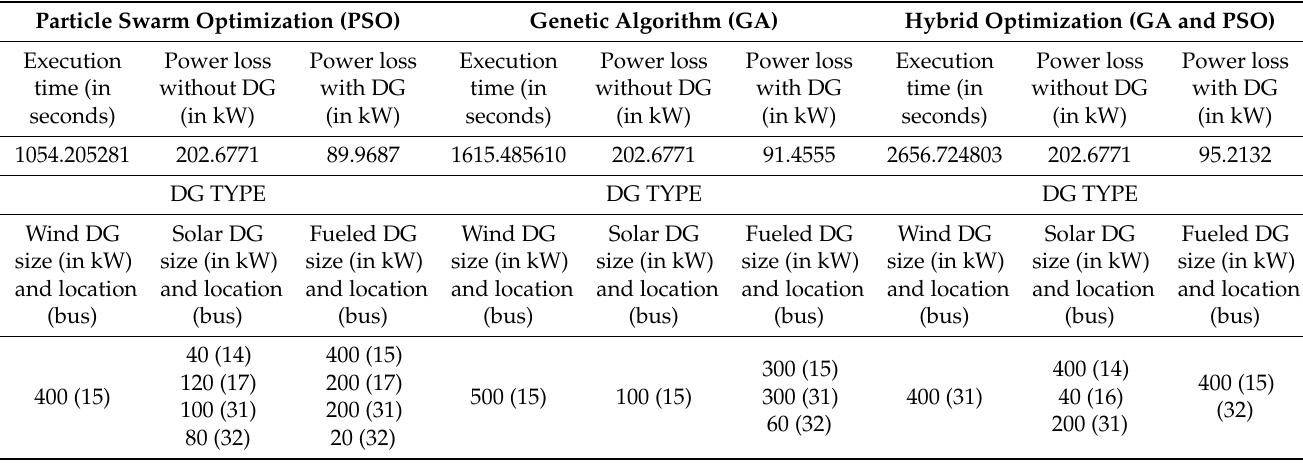
Table 6. Simulation results for optimal DGs size and their corresponding optimum location by MCS for scenario-1 using different metaheuristic optimization techniques.